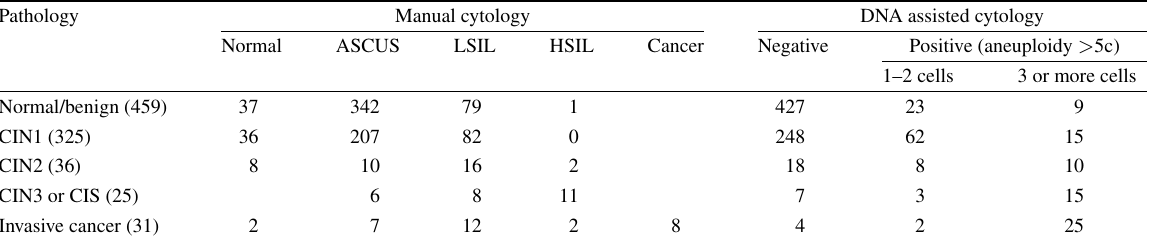
Comparative results of histopathology, conventional manual cytology and DNA assisted cytology of 876 biopsy